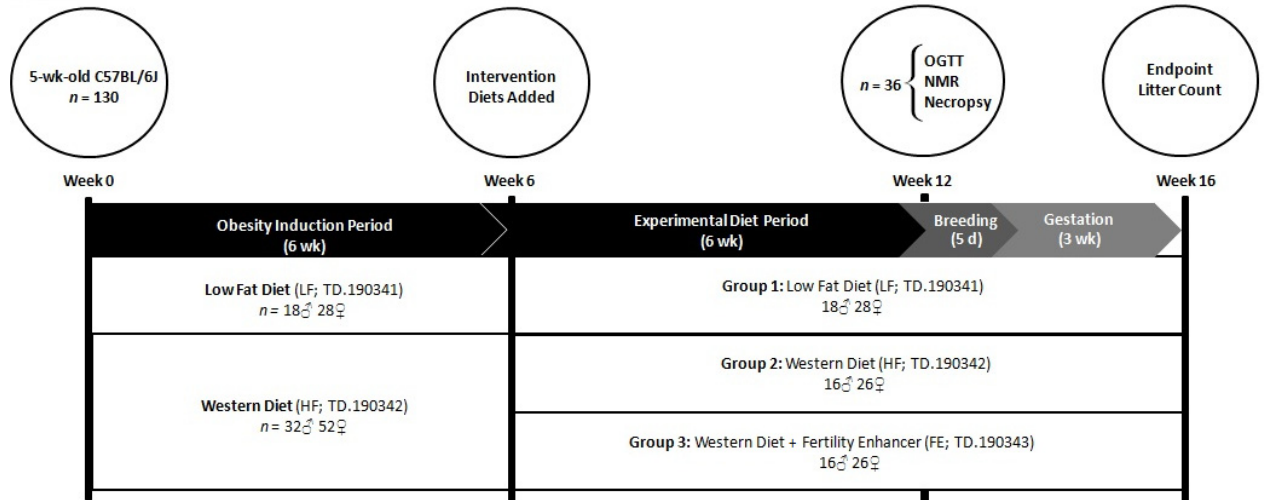
Figure 1. Study timeline for assessing the effects of the ‘Fertility Enhancer’ supplement on body- weight, WAT expansion, NAFLD, and fertility in WD-fed C57BL/6J mice.